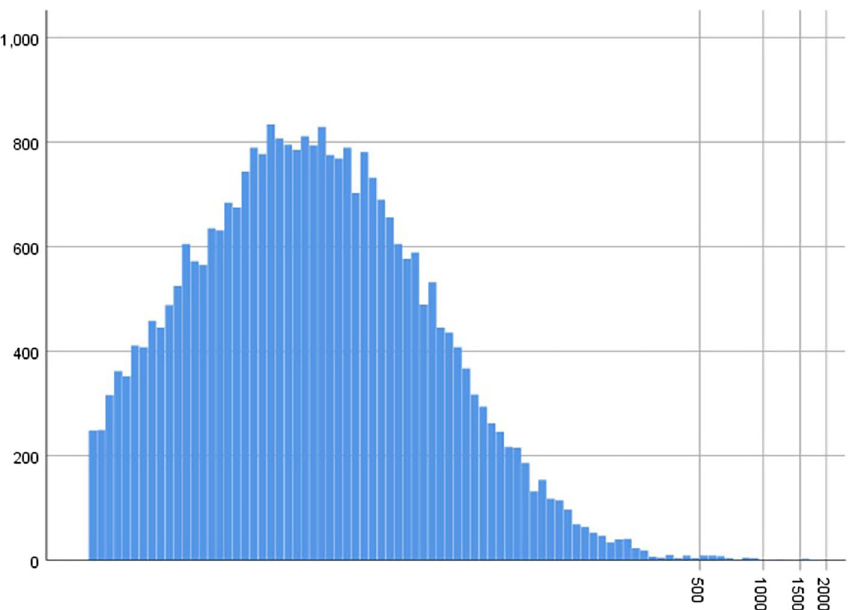
Figure 2. Concentration of the total serum IgE level. The horizontal axis indicates the log-transformed total serum IgE level, and the vertical axis indicates the number of